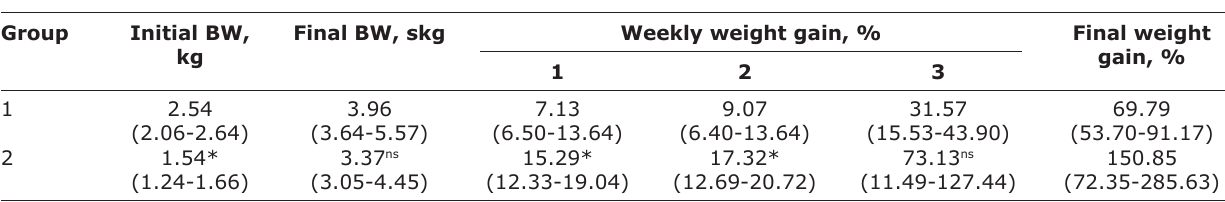
Table-2: BW and weight gain of piglets (Me [P25-P75]). Group